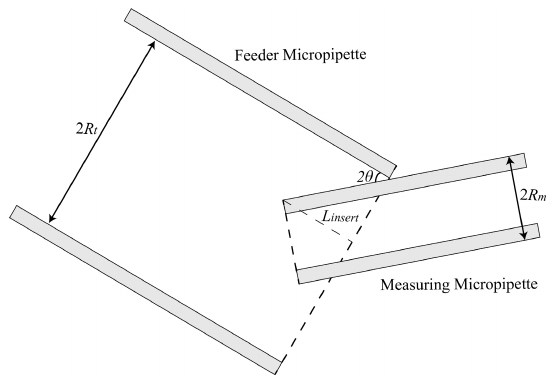
Figure 2. Schematic: The tilted measuring micropipette (MM) is just able to insert into the tilted feeder micropipette (FM).